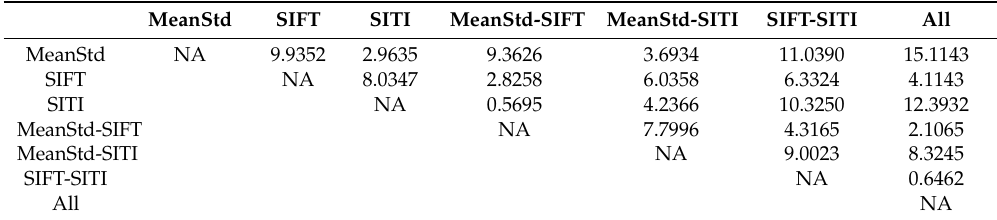
Table 5. McNemar’s test values of the different combination of